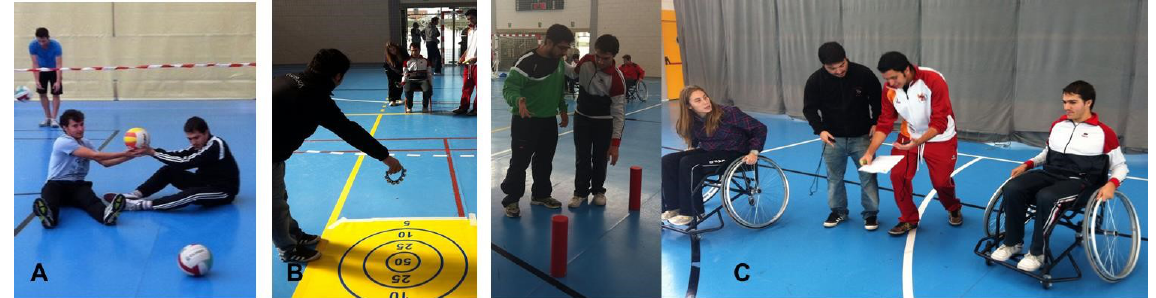
Figure 3. Teaching activities in adapted physical activity subject: sitting (A), limited arm movement (B), wheelchair (C)